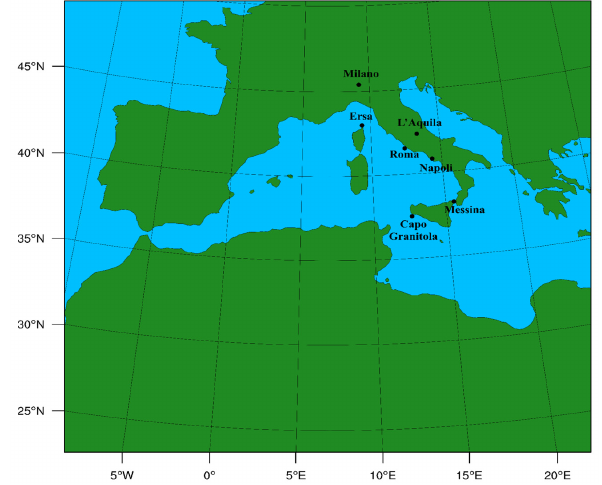
Figure 1. The WRF-Chem domain, the location of the ground-based remote sensing sites used in this study, including Aeronet stations (Ersa, Roma, L’Aquila, Napoli, and Messina) and sites of the Italian ALICEnet ceilometers network (Roma, Messina, Milano, and Capo Granitola).